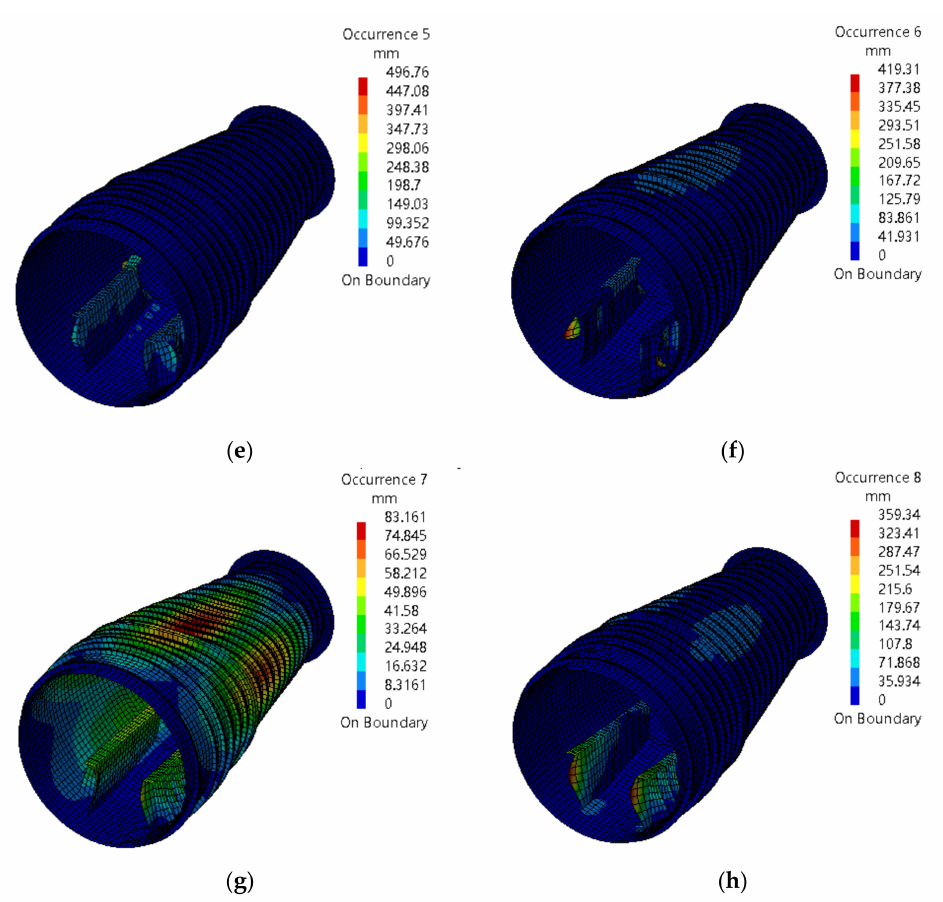
Figure 3. Coupled modal shape of the ring-stiffened conical shell in water: ( a ) 1st order; ( b ) 2nd order; ( c ) 3rd order; ( d ) 4th order; ( e ) 5th order; ( f ) 6th order; ( g ) 7th order; ( h ) 8th order.